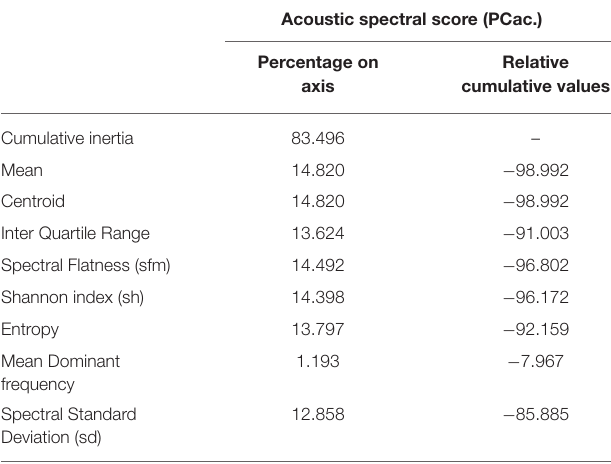
TABLE 4 | Variable loadings of the parameters used in the Principal Component Analysis to build a spectral acoustic score. Acoustic spectral score